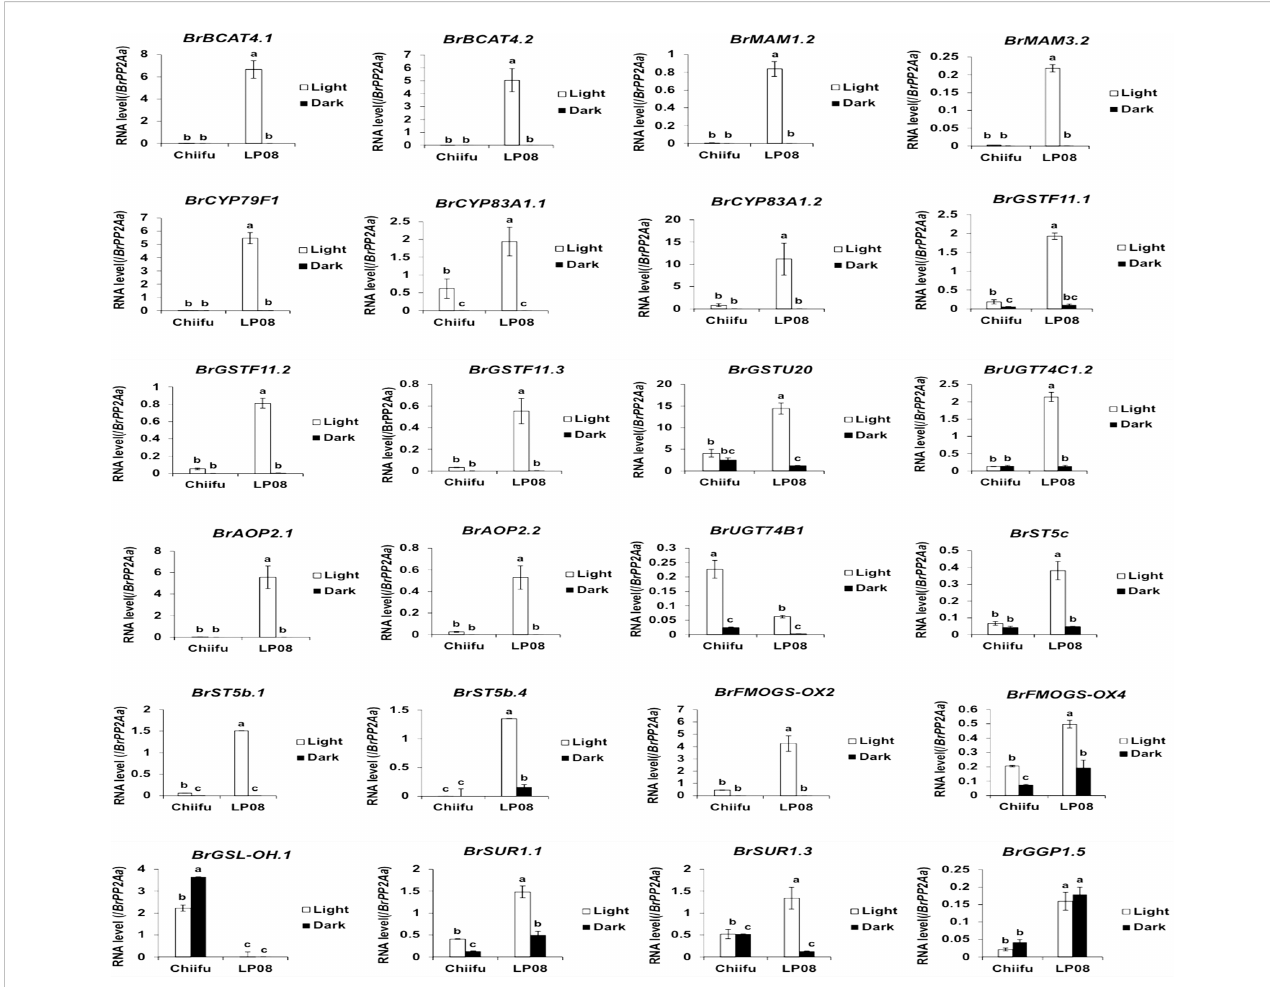
FIGURE 6 qRT-PCR analysis of 24 aliphatic GSL metabolic genes in ‘ Chiifu ’ and ‘ LP08 ’ grown under light and dark conditions. Results of qRT-PCR analysis of 24 metabolic genes involved in aliphatic GSL biosynthesis. White and black bars indicate the expression level of each gene under light and dark conditions, respectively. Average values and standard deviations were calculated using the threshold cycle (Ct) values of three biological replicates. Signi fi cance was statistically determined using one-way analysis of variance (ANOVA) and Tukey ’ s post-hoc test ( p < 0.05), and indicated with different letters above